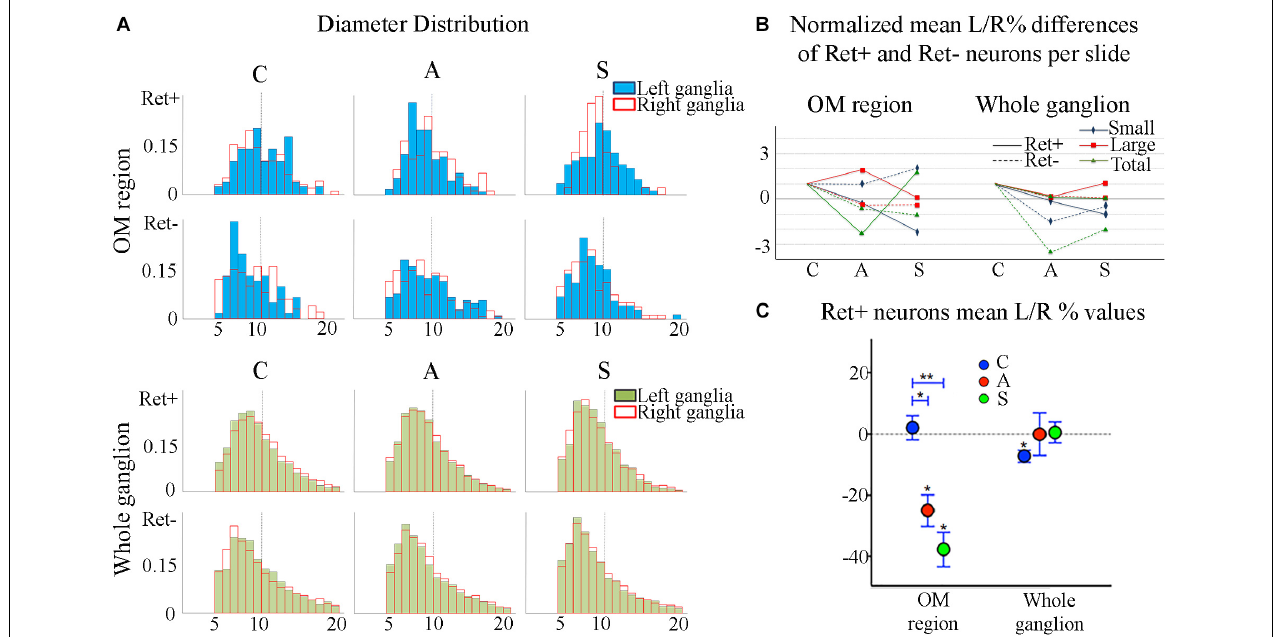
FIGURE 4 | (A) Normalized histograms displaying diameter distribution of RET-positive and RET-negative neurons of representative C, A, and S animals. Blue histograms correspond to neurons of the ophthalmic-maxillary (OM) area, green to the whole ganglion. Top line display RET-positive and bottom line RET-negative neurons in both cases. Black perimeter filled bars correspond to right/non-manipulated ganglia; red perimeter empty bars correspond to the left/manipulated ganglion. Dashed vertical line indicates the border between small to large diameter neurons (Ø = 20 µ m). Bin amplitude 2 µ m. Changes in left–right distributions passing from C to A and S animals reflect the effects of the deafferentation and of electrical stimulation described in the text. (B) Graphic representation of the normalized mean left–right percentage differences (L/R%) in the number of RET-positive and RET-negative neurons in C, A, and S animals. L/R% are shown separately for small, large and the totality of the neurons in the ophthalmic-maxillary division (OM, left) and of the whole ganglia (right). Normalization was performed by dividing C, A, and S values by C value. (C) Comparison of L/R% for RET-positive neurons in the ophthalmic-maxillary region and the whole ganglion. Left: in OM, control TG neurons display a slightly positive L/R% (blue circles), which is transformed to a significant negative L/R% after axotomization (red circles, paired t -test, P < 0.05) and it becomes even stronger under electrical stimulation of the transected nerve (green circles). Right: in the whole ganglion, RET-positive neurons show a significant negative L/R% in control animals that is abolished following axotomization and axotomization+electrical stimulation of the stump (red and green circles respectively).